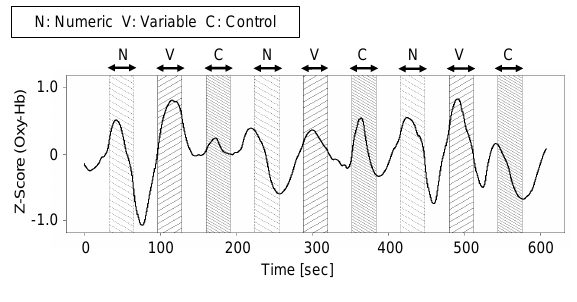
Fig. 7. Brain activity in Program task.